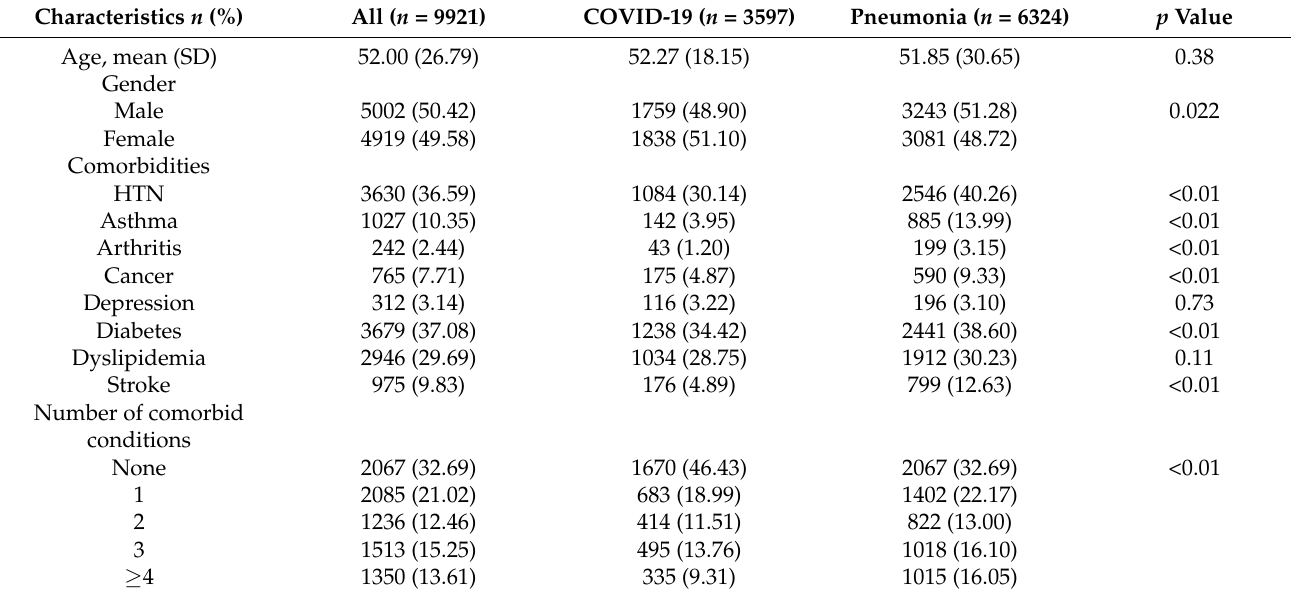
Table 1. Baseline demographic and clinical characteristics of patients admitted to hospital due to COVID-19 or pneumonia, NGHA, Saudi Arabia.